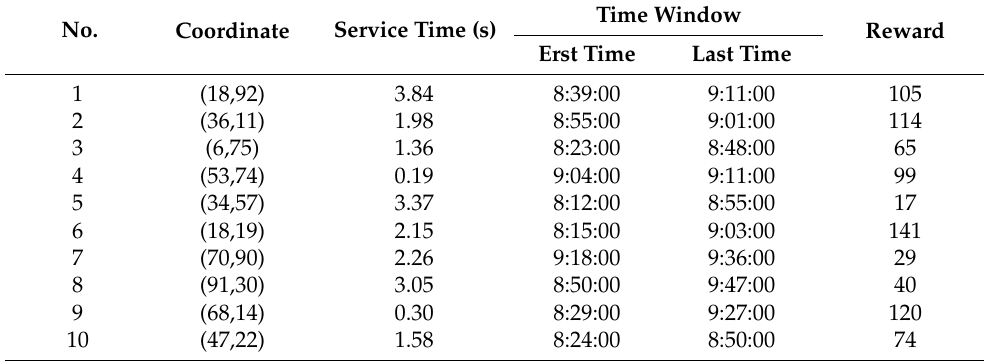
Table 3. Parameter of Initial Tasks.